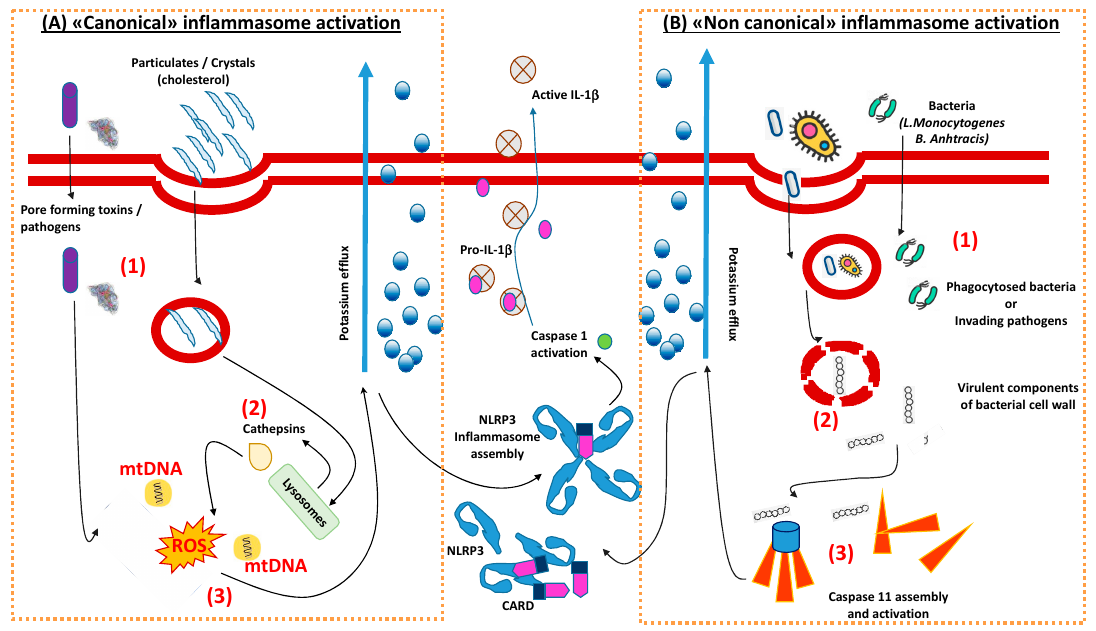
Figure 1. Summary of cellular mechanisms leading to the activation of the NLRP3 inflammasome. Depending on the pathogenic activator, two different types of cellular mechanisms lead to the assembly and activation of NLRP3 inflammasome, crucial for the production of atherogenic molecules (interleukin (IL)-1 β ). ( A ) The “canonical pathway” is (1) activated by the phagocytosis of molecular products (e.g., cholesterol crystals in the atherosclerotic lesion) or peculiar pathogen-associated molecules or cellular stimuli (e.g., ATP via the P2X7 receptor), and involves (2) the activation of lysosomial cathepsins and (3) pro-apoptotic mitochondrial signals. ( B ) The “non-canonical pathway” evolutionary developed for the phagocytosis of peculiar bacterial species, (1) either by endocytosis or by direct invasion; this in turn (2) activates programmed digestion of these products with the release of virulent proteins from the wall membrane of bacteria which (3) induce the assembly of caspase 11. Both mechanisms induce massive e ffl ux of potassium, which is then crucial for the assembly of the components of the NLRP3 inflammasome. This will finally turn pro-caspase 1 into active caspase 1 to favor the release of the final mature form of IL-1 β . mtDNA, mitochondrial DNA; ROS, reactive oxygen species; CARD, caspase activation and recruitment domain.